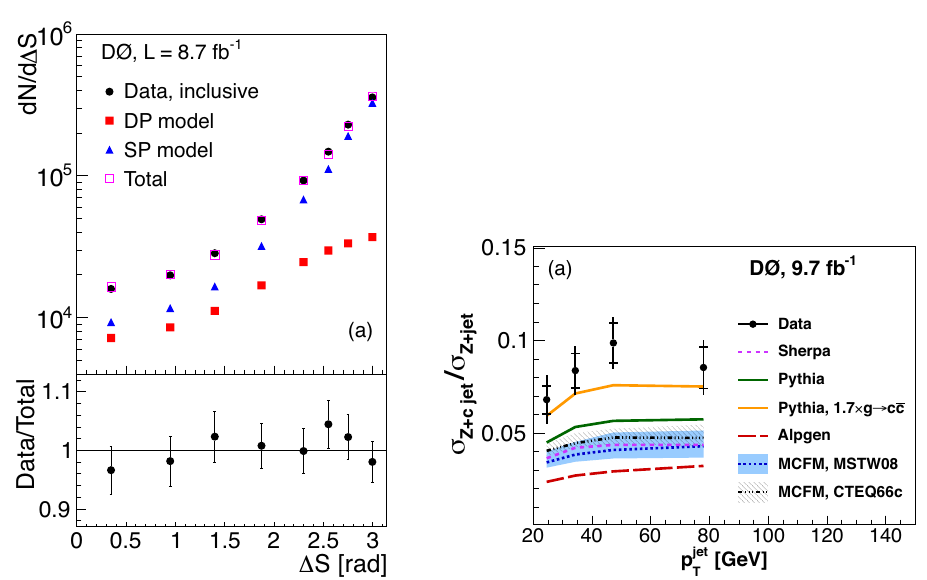
Figure 8. Studies of multi-parton interactions in p ¯ p collisions at DZero, in photon + 3 jets production (left) and in Z + charm production (right).